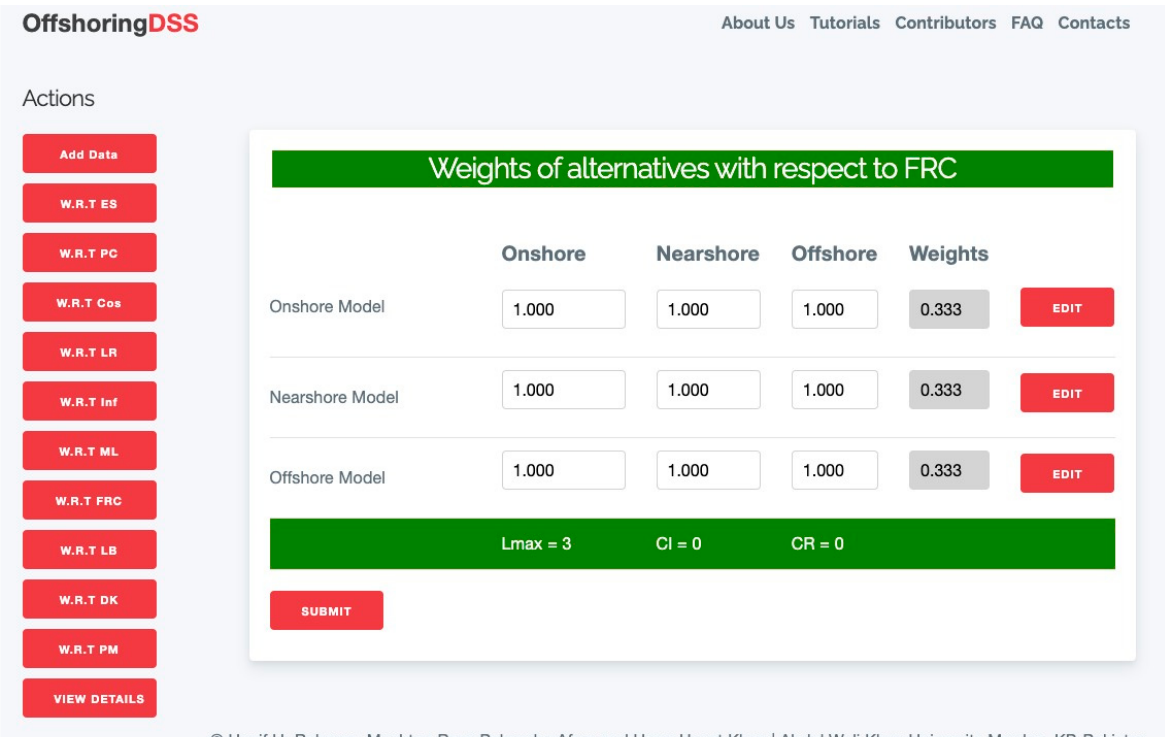
Figure A5. Alternatives weights with reference to ML and CR.